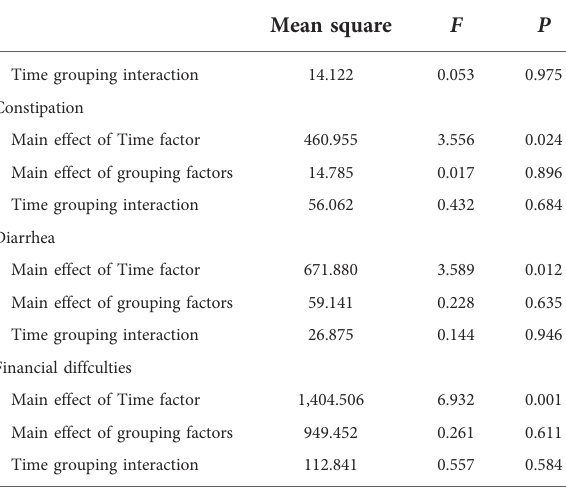
TABLE 4 Quality of life scores in IVMTE and MIME using